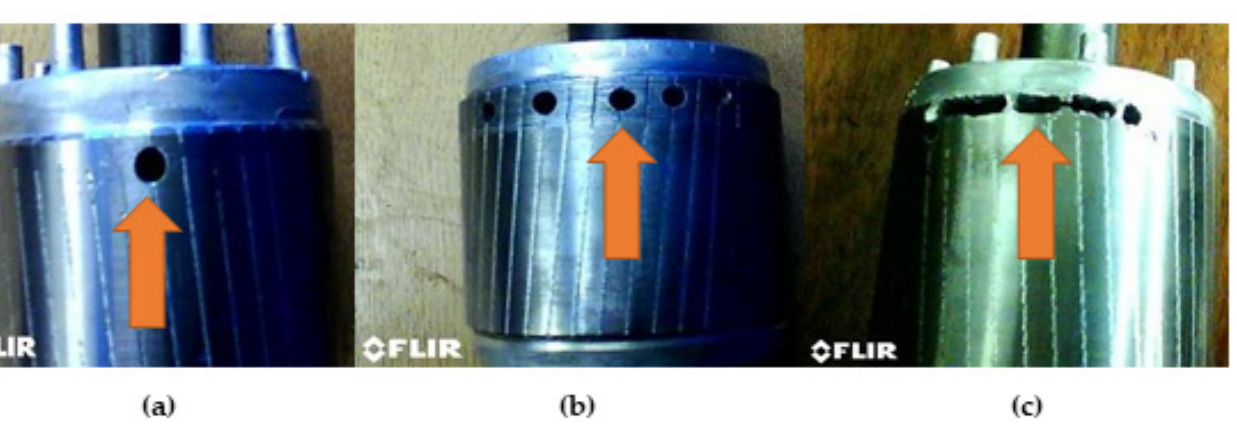
Figure 3. Bearing faults. ( a ) Ball-bearing fault; ( b ) Outer-bearing fault; ( c ) Inner-bearing fault.